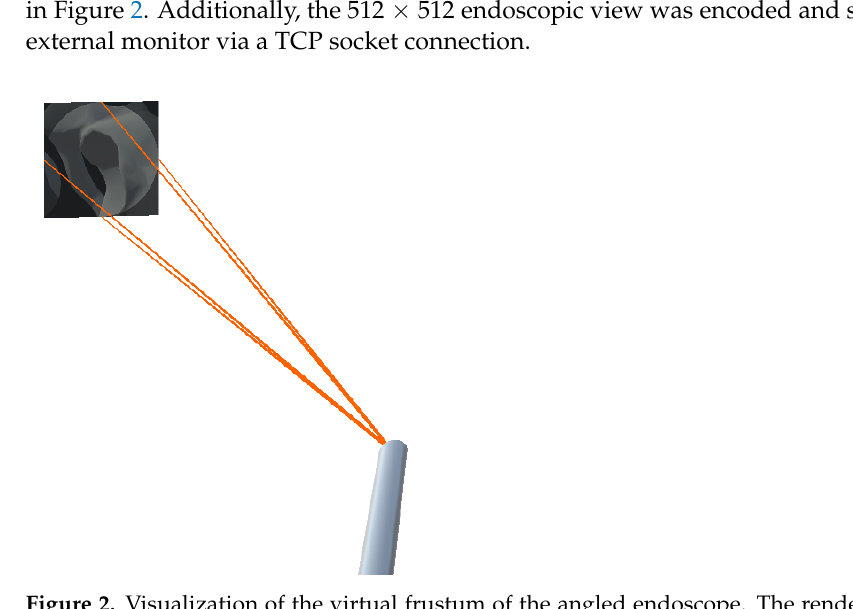
Figure 2. Visualization of the virtual frustum of the angled endoscope. The rendered image was projected onto the far clipping plane of the virtual